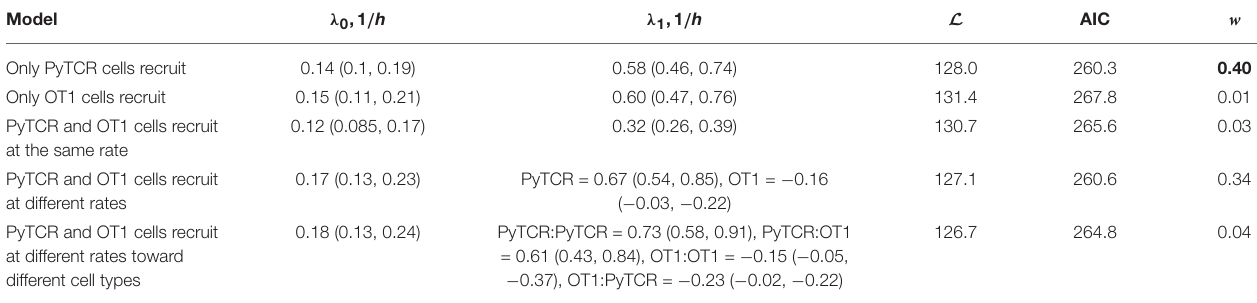
TABLE 2 | Comparing alternative models which assume different contributions of Py-specific (PyTCR) and non-specific (OT1) T cells to cluster formation.